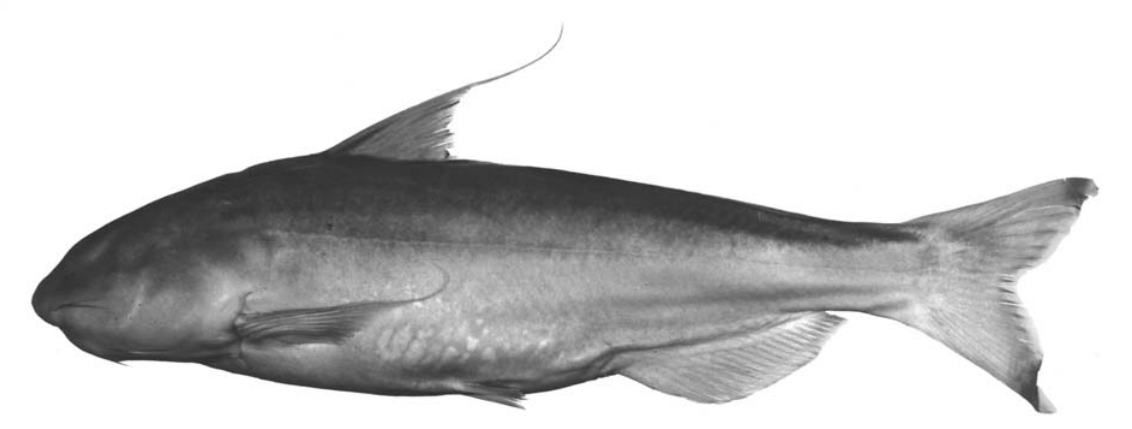
S Fig. 18. Cetopsis coecutiens, MCNG 5262, 216 mm SL; Venezuela, Apure, río Sarare, between Las Bocas and Guasdualito (7 o 11’50"N, 71 o F lique to long axis of body. Anterior margin of posterior narial opening with low flap of skin. Distance between contralateral posterior nares only slightly larger than diameter of eye. O O R P